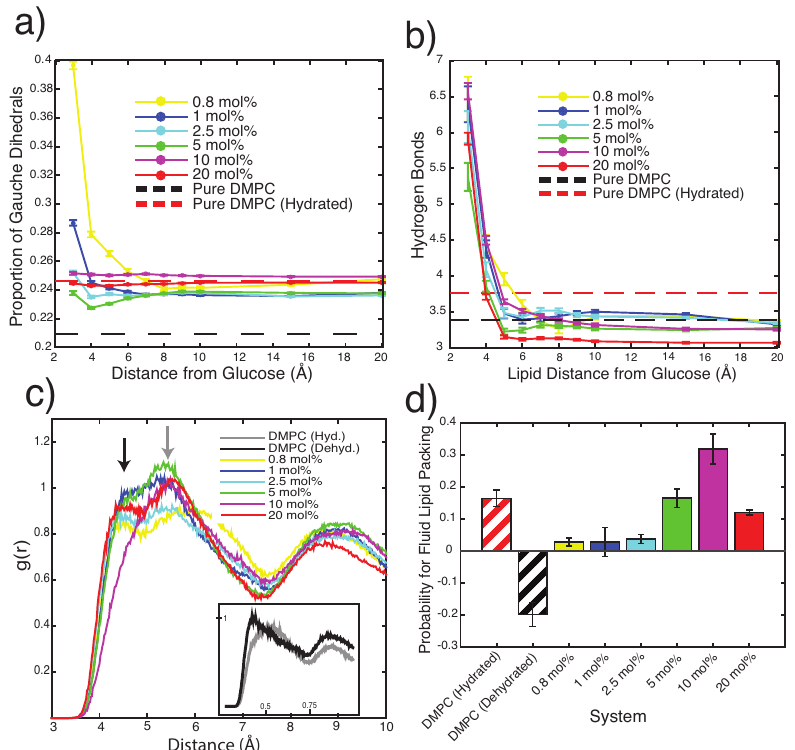
Figure 4. ( a ) Proportion of gauche dihedrals of SN1 and SN2 tails of DMPC at varying distances from glucose molecules. ( b ) Number of hydrogen bonds per lipid at varying radial distances from glucose. ( c ) Radial distribution functions for phosphate-to-phosphate distances in each lipid system. The dehydrated DMPC system exhibits a nearest phosphate peak at 4.5 Å, the hydrated DMPC system shows a broader peak at 5.5 Å. Sugar-lipid systems display a split peak between these values, indicating variation between hydrated and dehydrated lipid bilayer packing. ( d ) Difference between radial distribution function probability values at the hydrated peak position (5.5 Å) and the dehydrated peak position (4.5 Å). Positive differences indicate higher probability at the fluid